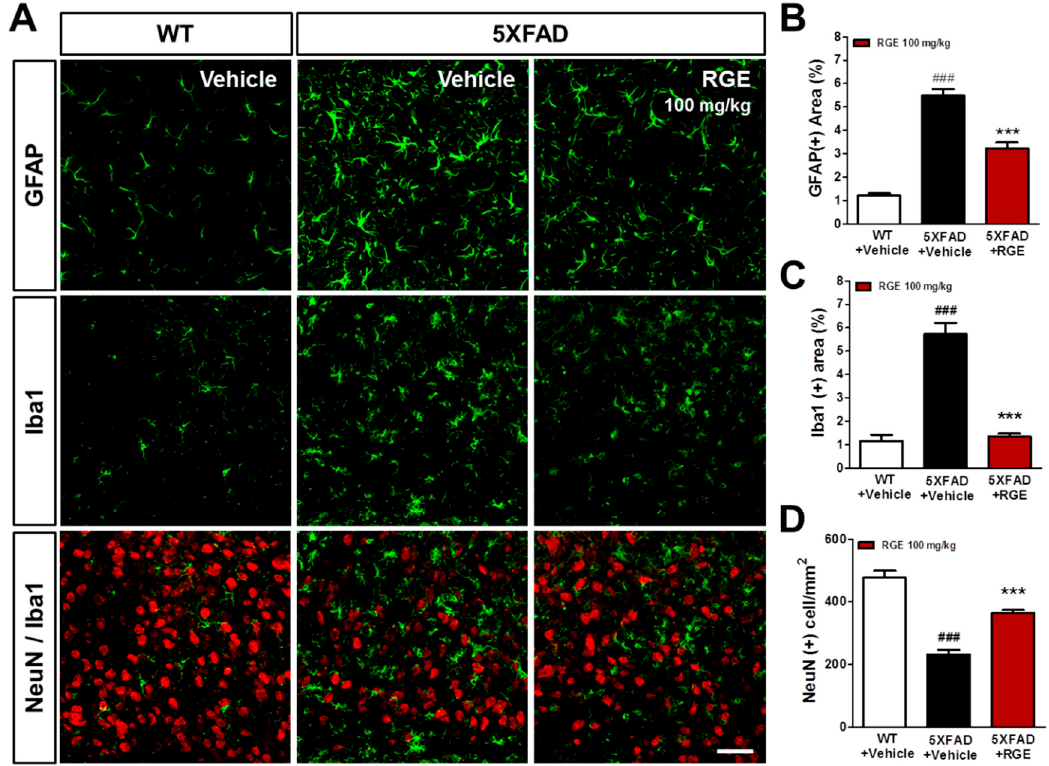
Figure 4. Effects of RGE on neuroinflammation in the subiculum of 5XFAD mice. ( A ) Immunofluorescent staining was conducted with the markers of microglia (ionized calcium-binding adapter molecule 1, Iba-1), astrocytes (glial fibrillary acidic protein, GFAP), and neurons (neuronal nuclei, NeuN) in the subiculum (scale bar = 100 μ m). ( B ) The significantly greater GFAP-positive areas in 5XFAD mice compared to those in WT mice were significantly reduced by RGE administration. ( C ) The significantly greater Iba1 (+) areas in 5XFAD mice compared to those in WT mice were significantly reduced by RGE administration. ( D ) The number of NeuN (+) cells per area was significantly reduced in 5XFAD mice compared to those in WT mice and significantly improved by RGE administration. Data are presented as mean ± SEM. *** p < 0.001: vehicle-treated WT mice (white bar) versus vehicle-treated 5XFAD mice (gray bar). ### p < 0.001: vehicle-treated 5XFAD mice versus A β + RGE-treated 5XFAD mice (black bar).